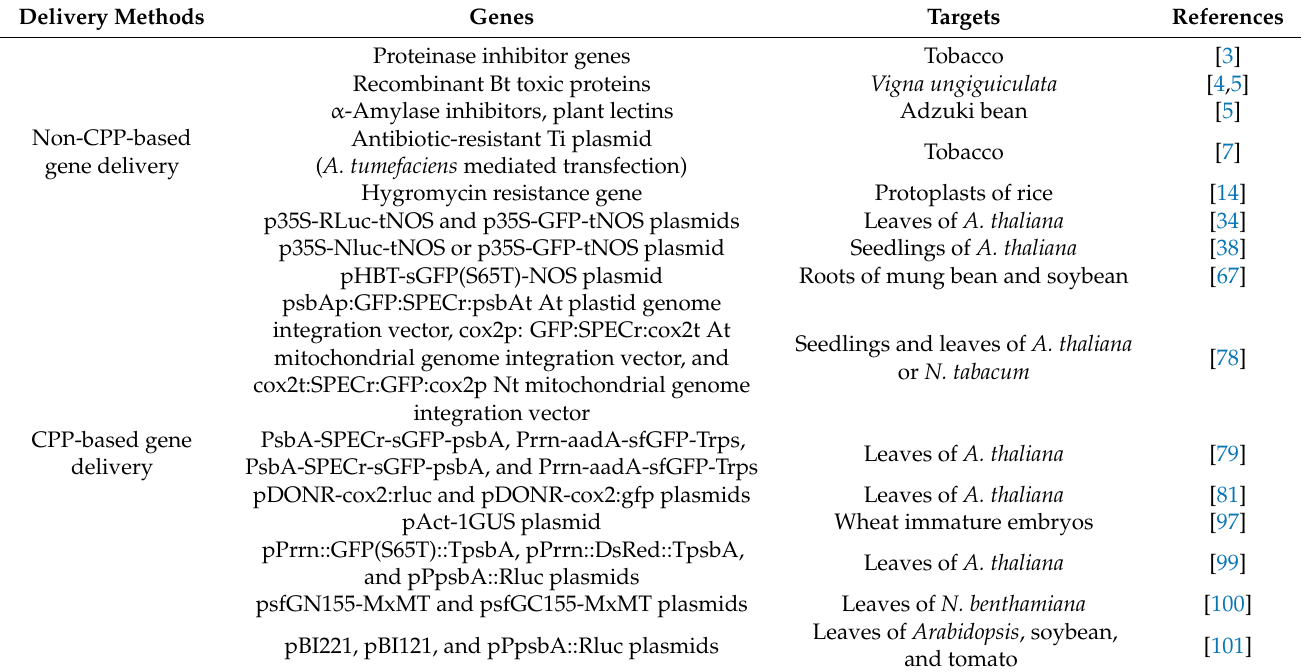
Table 2. List of various genes applied in transgenic